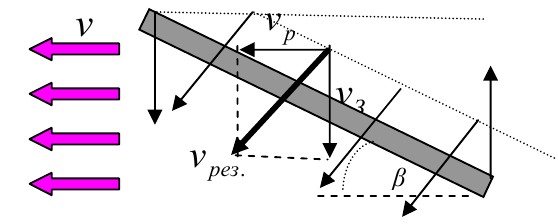
Figure 2 – Scheme of the displacement